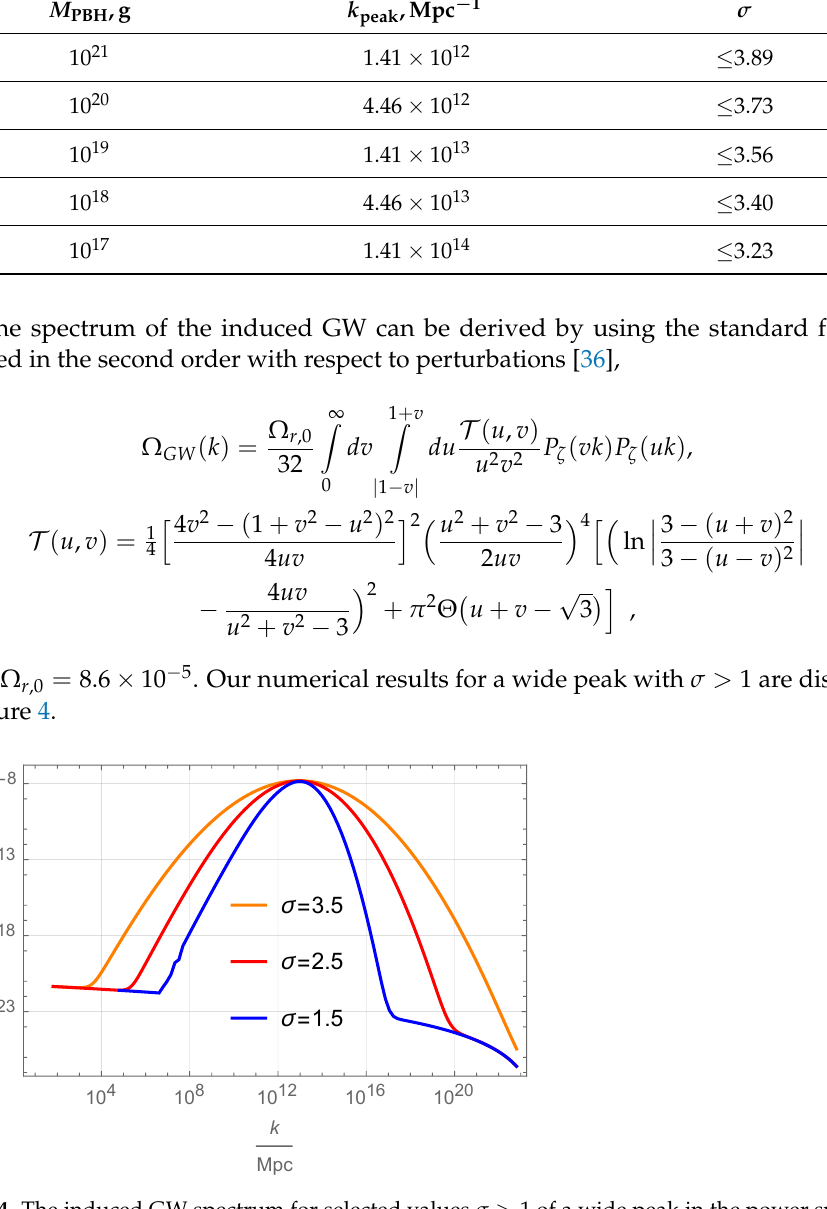
M PBH ,g k peak ,Mpc − 1